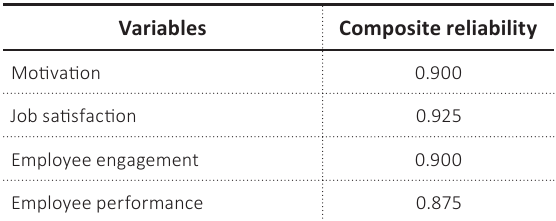
Table 4. Composite reliability